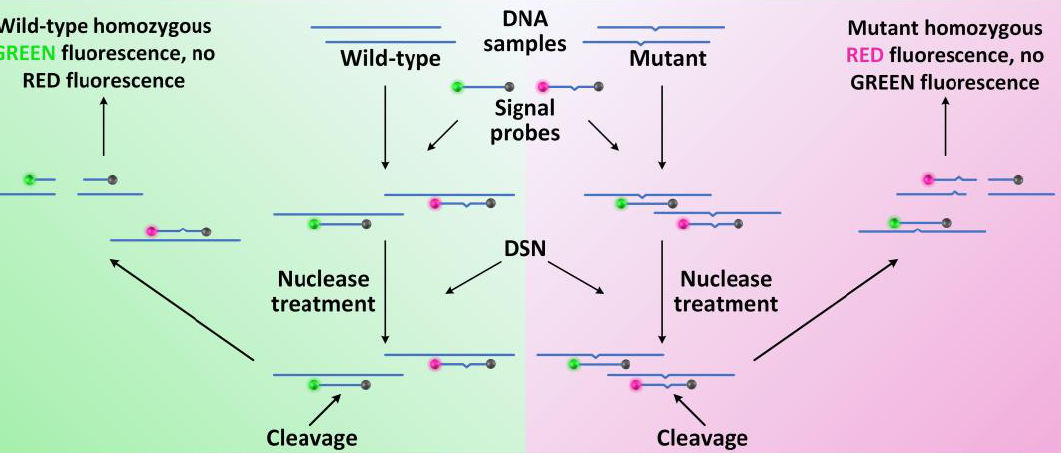
Figure 6. Scheme of the common DSNP assay for SNP detection. The green luminescent ball represents the first fluorescent donor, the red luminescent ball represents the second fluorescent donor, and the gray ball represents the fluorescent quencher. Reproduced with permission from Ref.